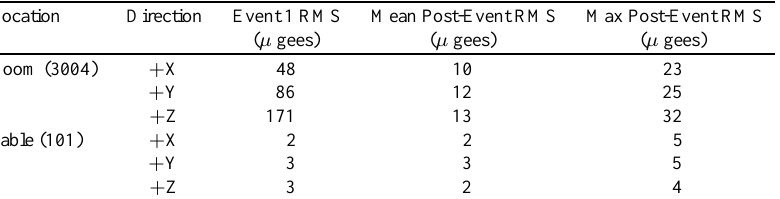
Table 4 Comparison of Band-Limited RMS for Sliding Time Windows During and Following Event 1